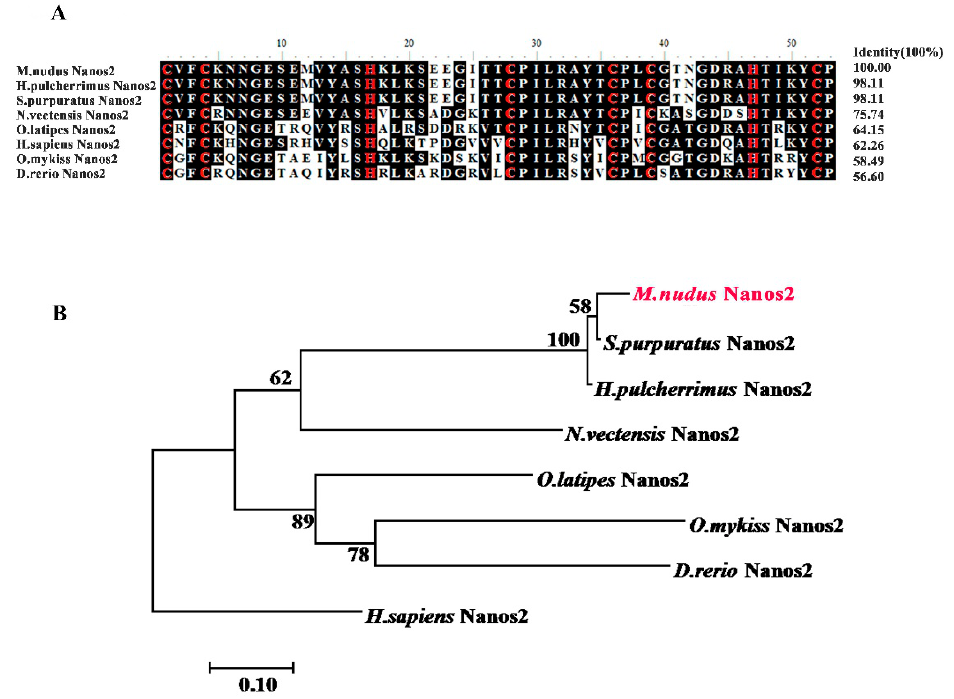
Figure 2. Sequence analysis of Nanos2 in M. nudus . ( A ) Multiple amino acid sequence alignment of Nanos2 ZF-domain, The 8 invariant cysteine and histidine residues in zf-domin were marked with red color. ( B ) phylogenetic tree of Nanos2.Nanos2 Amino acid of Mesocentrotus nudus was marked with red color. The phylogenetic tree was constructed with MEGA version 5.0 by bootstrap analysis using the maximum-likelihood method (1000 replicates) and human Nanos2 was used as the outgroup sequences.